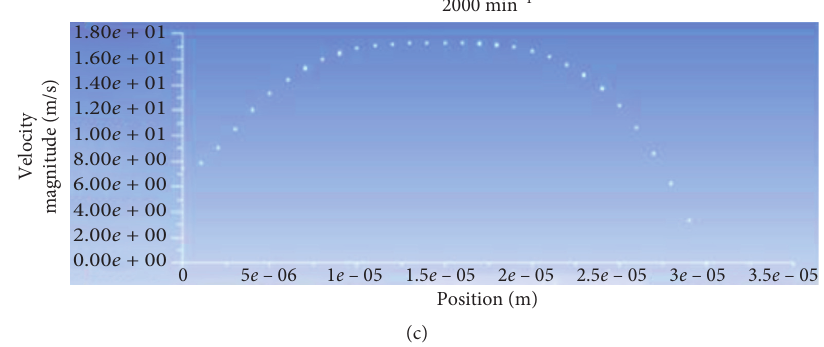
Figure 13: Speed scatter plot of the outlet of the internal gear area along the clearance direction at each speed.